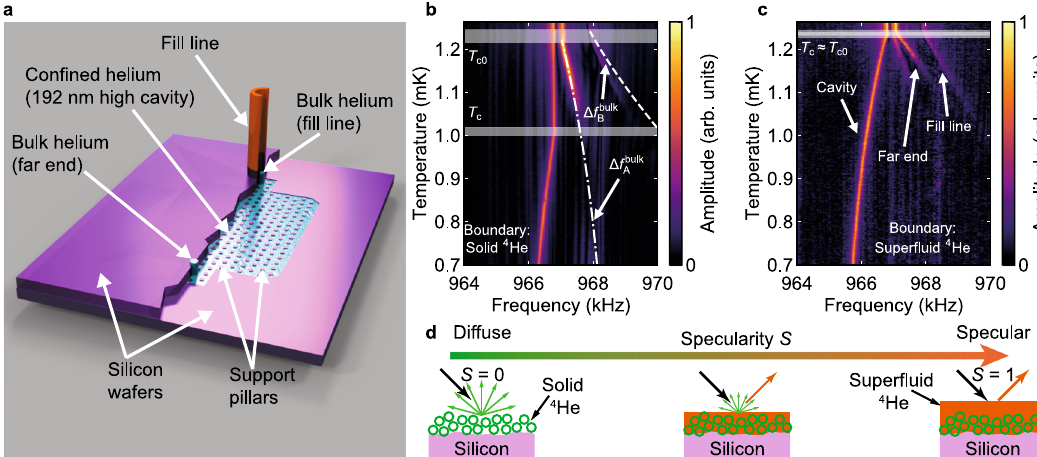
Fig. 1 Experimental cell con fi ning 3 He. a Nanofabricated sample cell, cut away to show cavity in lower silicon wafer, bonded to upper wafer. The support posts shown maintain cavity height D under different liquid pressures. The cavity is fi lled through a fi ll line via a sintered heat exchanger and cooled through the column of 3 He within it. Small volumes of bulk liquid at each end of the cavity provide markers for the bulk super fl uid transition T c0 , and eliminate thermometry errors due to temperature gradients. The NMR coil set around the sample is shown in Supplementary Fig. 1. Suitable small magnetic fi eld gradients are used to resolve the NMR response of different regions of the cell, see ‘ Methods ’ . b , c NMR signatures of super fl uid transition in cavity and bulk markers, for two different surface boundary conditions, at 3 He pressure of 2.46 bar. 3 He-A in the cavity shows a negative frequency shift whereas the bulk markers show positive frequency shift; Δ f bulk and Δ f bulk refer to the calculated bulk super fl uid frequency shifts of 3 He-A and 3 He-B, respectively, see A B Supplementary Note 2. The T c suppression observed with a surface boundary layer of solid 4 He is eliminated by the addition of 4 He to create a super fl uid T ‘ Methods ’ . 4 He fi lm at the surface. The white horizontal bands show the measured T c and c0 including the uncertainties in temperature determination, see d Schematic illustration of the tuning of surface scattering conditions, parametrised by specularity coef fi cient S , by surface plating atomically smooth silicon with a 4 He fi lm. The green circles represent 4 He atoms, the orange is liquid 4 He, and the arrows indicate the fl ux of incoming and outgoing 3 He